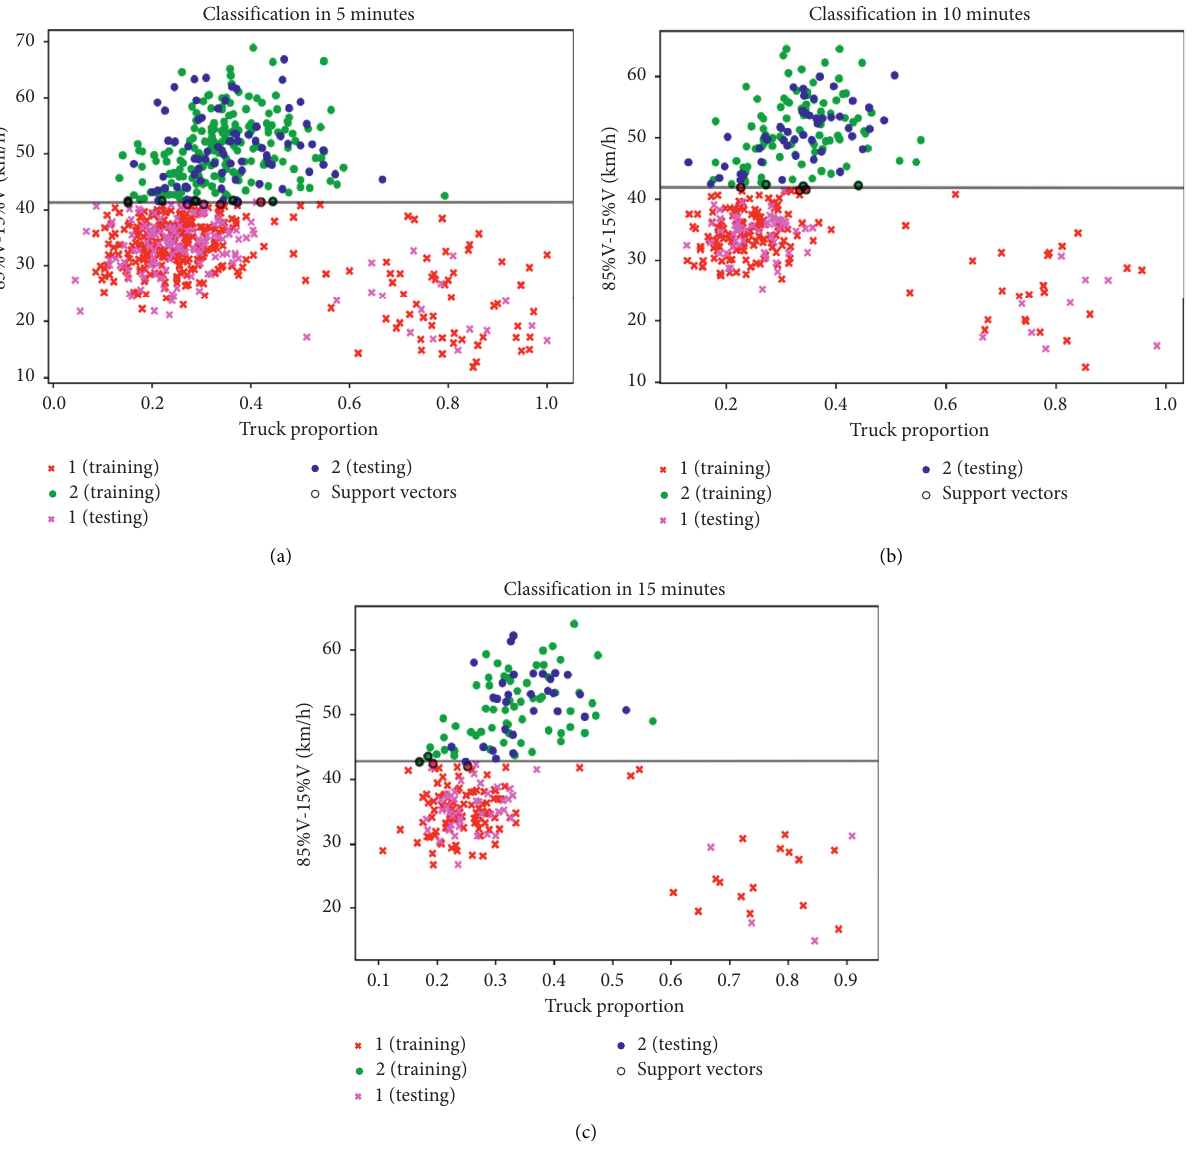
Figure 2: Classification diagram of the support vector machine of